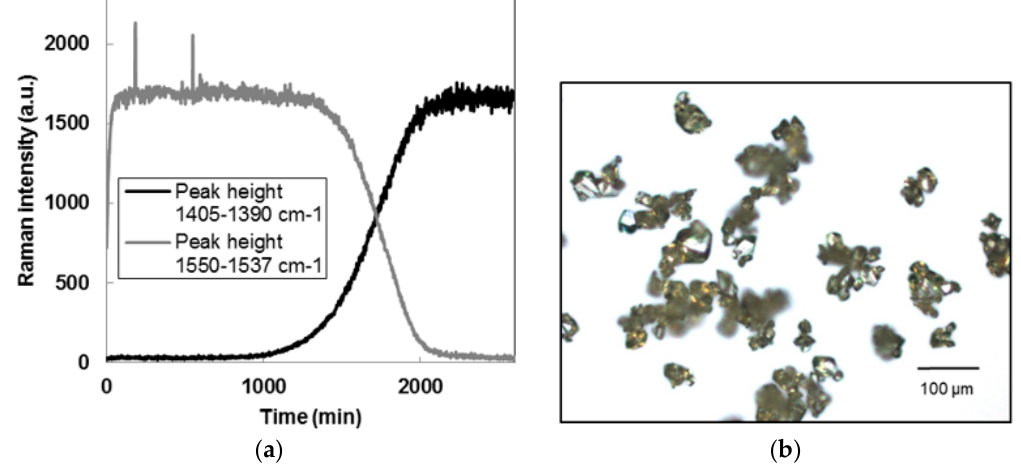
Figure 5. ( a ) Raman signal during polymorphic transformation from form I piroxicam to monohydrate; ( b ) Microscopic image of the monohydrate crystals obtained at the end of the experiment.